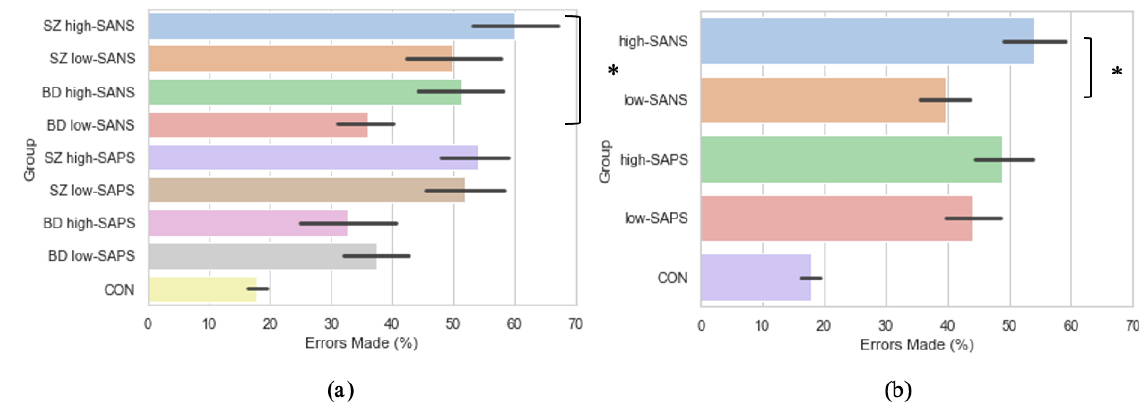
Figure 6. A comparison of error production across the memory-guided saccade paradigm in ( a ) diagnostic groups divided by symptomatology, and ( b ) symptom groups (regardless of diagnostic criteria). For reference, the control cohort are included here but were not included in the reported analysis. * Refers to significance at the p < 0.05 level. Error bars refer to the standard error.